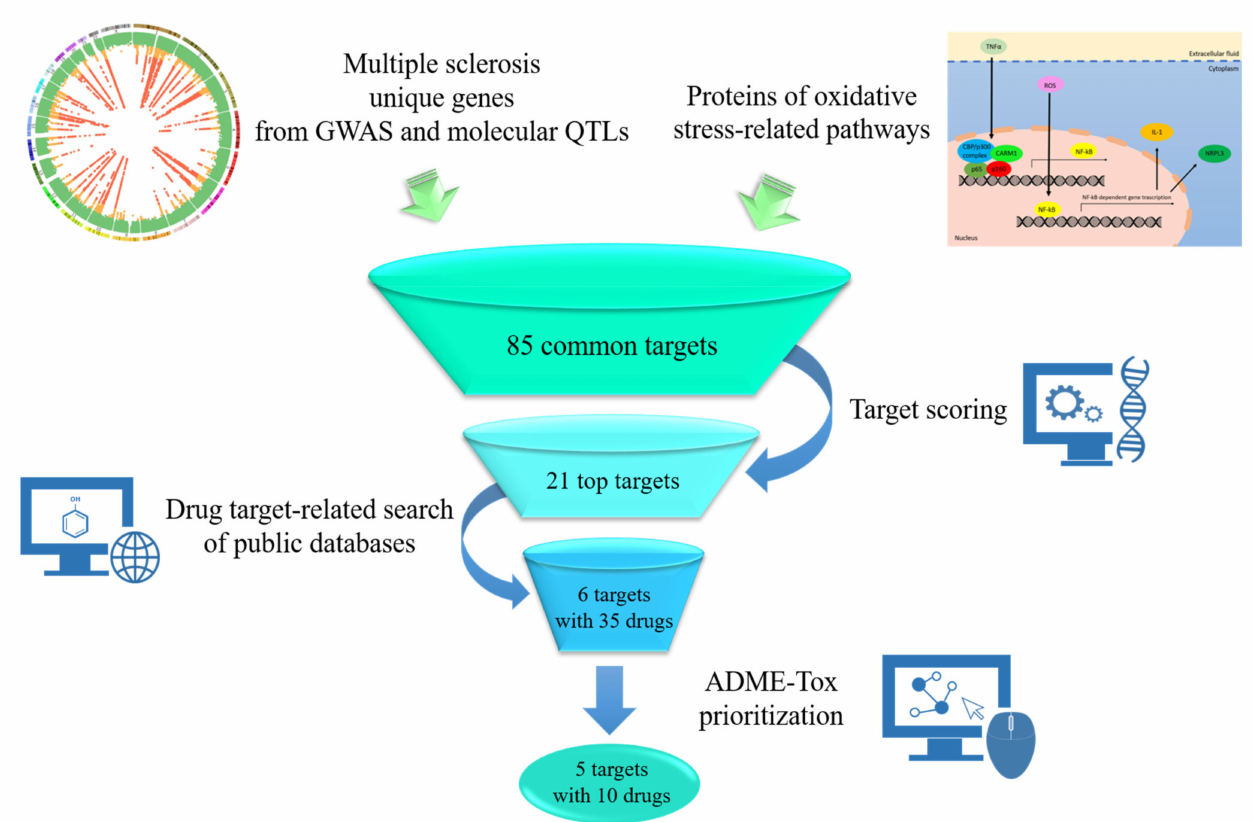
Figure 1. Schematic illustration of the in silico workflow. Multiple sclerosis (MS) genetic variants were collected from the Genome-Wide Association Studies (GWAS) Catalog and molecular Quantitative Trait Loci (QTLs) were exploited for each hit in the LinDA browser to identify gene targets. In parallel, all proteins from 22 oxidative stress-related pathways were retrieved from the Reactome database. The overlap of these data allowed for the identification of 85 common targets which were then prioritized through score assignment. Query of public drug databases for the 21 top targets enabled the selection of 35 drugs either already approved or in clinical trials that bind to six MS molecular targets. Absorption, Distribution, Metabolism, Excretion and Toxicity (ADME-Tox) selection highlighted 10 drugs with CNS localization and oral bioavailability for repurposing in